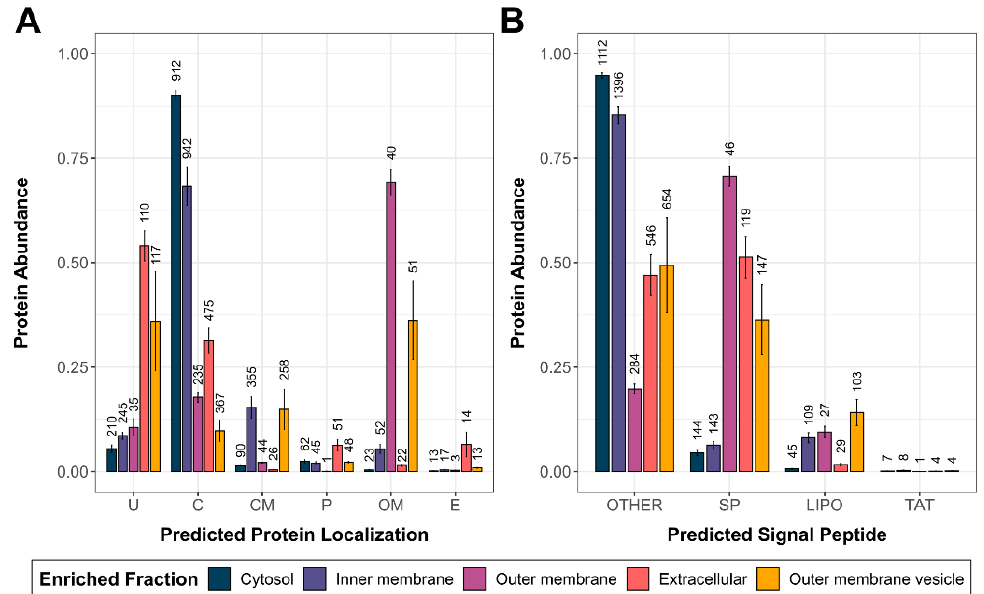
Figure 1. Overview of the predicted protein localizations and the presence of proteins with signal peptides within the enriched subcellular fractions of the Ctrl condition. ( A ) Quantified proteins were grouped according to their PSORTb-predicted protein localization (U—unknown; C—cytoplasmic; CM—cytoplasmic membrane; P—periplasmic; OM—outer membrane; E—extracellular). The protein abundances of these groups were normalized, and the distribution within the enriched subcellular fractions of the Ctrl condition was plotted. The number of quantified proteins within the enriched fractions is indicated above the bars. Error bars indicate standard deviations between replicates ( n = 4). ( B ) Quantified proteins were grouped according to their SignalP-predicted presence of signal peptides (OTHER—no predicted signal peptide; SP—Sec translocon/signal peptidase I; LIPO—Sec translocon/signal peptidase II; TAT—Tat translocon/signal peptidase I). The protein abundances of these groups were normalized, and the distribution within the enriched subcellular fractions of the Ctrl condition was plotted. The number of quantified proteins within the enriched fractions is indicated above the bars. Error bars indicate standard deviations between replicates ( n = 4).